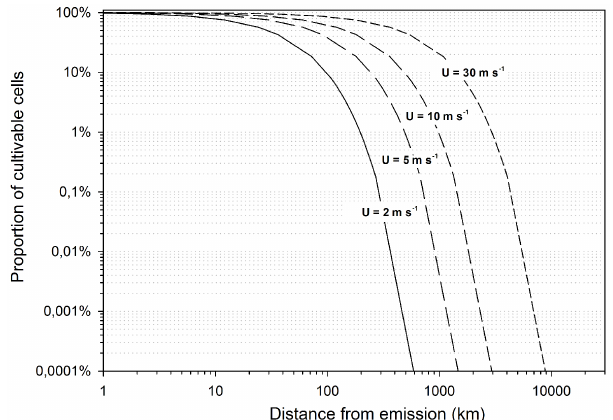
Figure 3. Proportion of cultivable airborne cells associated with the distance reached from their emission source for typical hor- izontal wind velocities (2. 5. 10 and 30ms − 1 , i.e. 7.2, 18, 36 and 108kmh − 1 , respectively), relative to the respective initial cul- tivability, as inferred from the data presented in Fig. 2. The propor- tion of 0.0001% is reached in 3.4 days, the mean residence time of bacteria in the atmosphere estimated by Burrows et al.